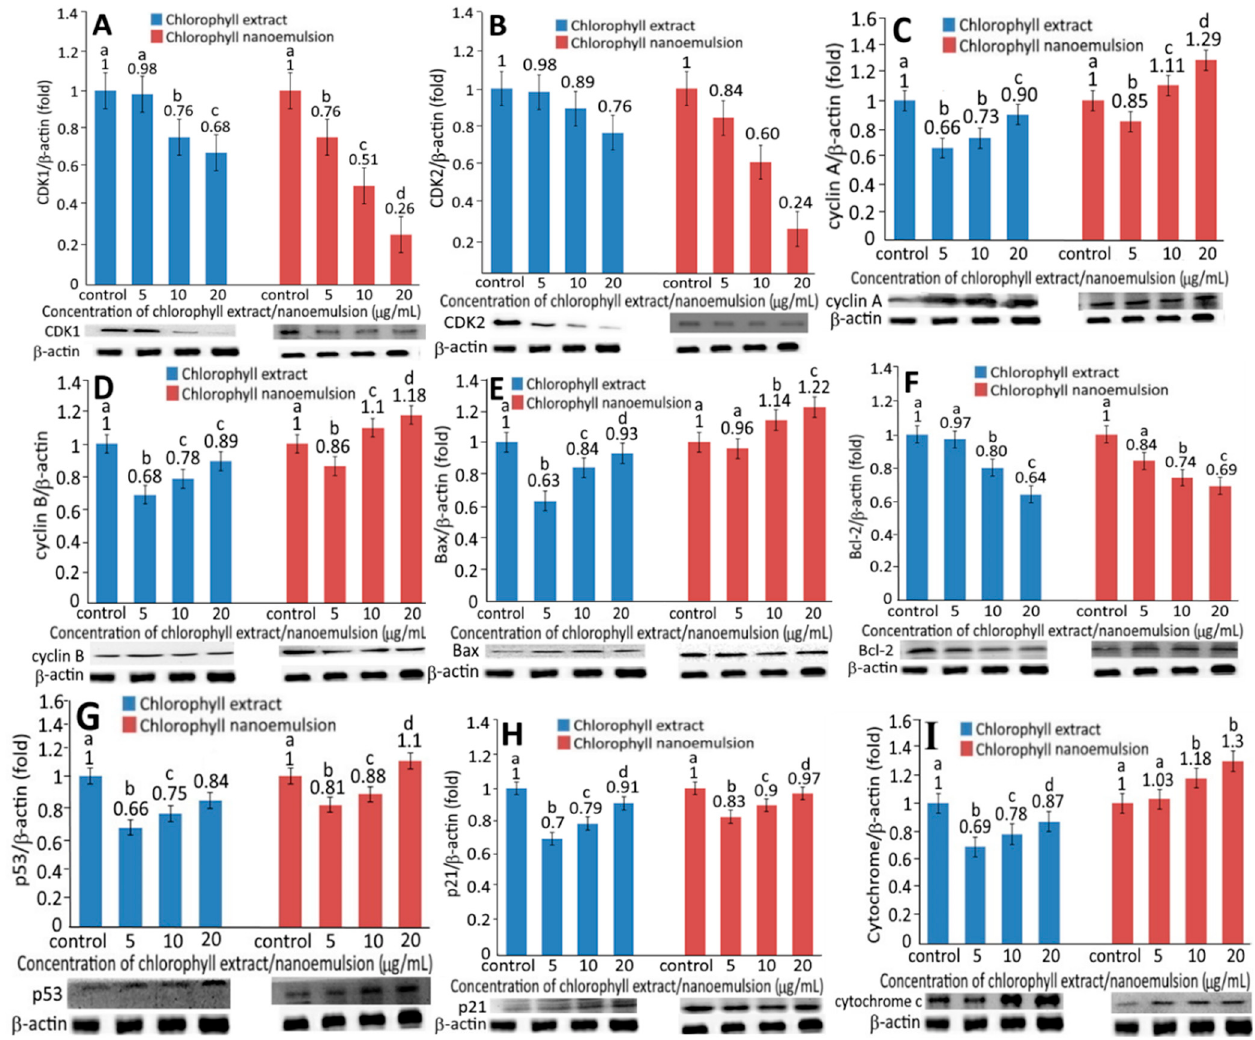
Figure 5. Effect of chlorophyll extract and nanoemulsion on protein expressions of CDK1 ( A ), CDK2 ( B ), cyclin A ( C ), cyclin B ( D ), Bax ( E ), Bcl-2 ( F ), p53 ( G ), p21 ( H ) and cytochrome C ( I ). For control, cells were incubated with medium only. Data represent mean ± standard deviation ( n = 3) with different letters (a–d) within the same treatment indicating significantly different values at p < 0.05.